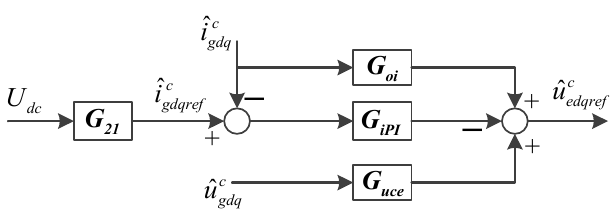
Figure 11. The small-signal transfer diagram of the GSC control excepting PLL.